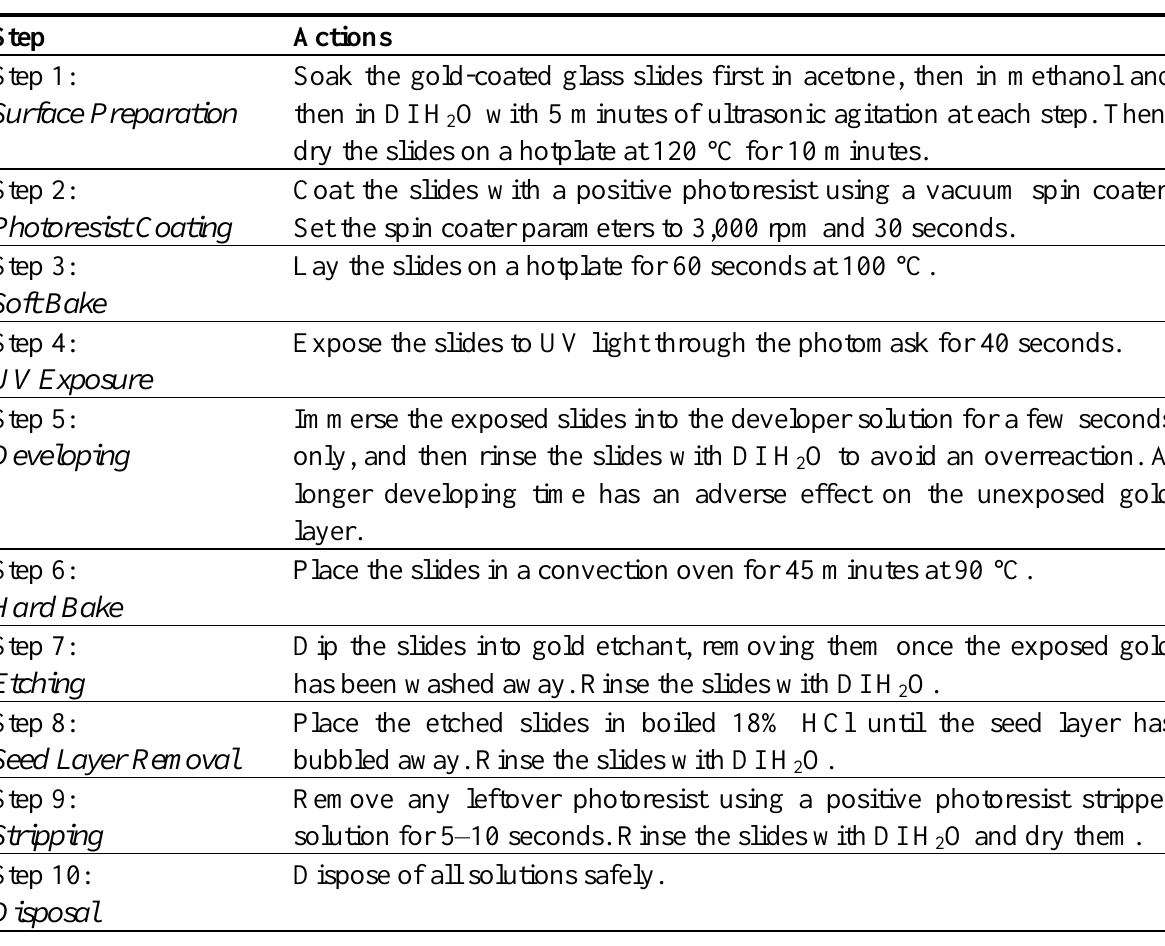
Table 1. The procedure for fabricating a gold microelectrode using a positive photoresist with the photolithography